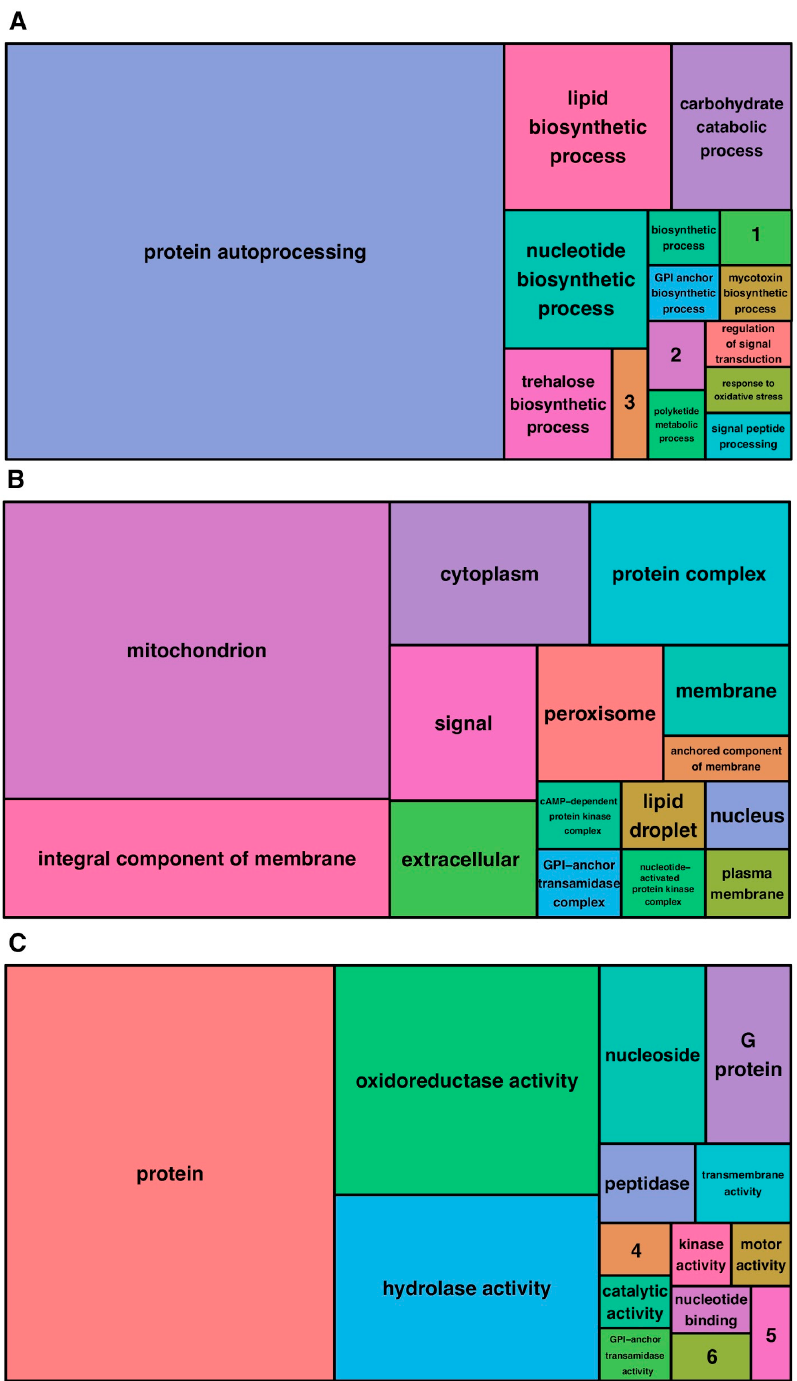
Figure 1. GOFeat annotation: Distinct identified genes proportionally displayed by main Gene Ontology categories. ( A ) Biological process. ( B ) Cellular component. ( C ) Molecular function. 1 aflatoxin biosynthetic process. 2 G protein-coupled receptor signaling pathway. 3 pathogenesis. 4 alpha,alpha-trehalose-phosphate synthase (UDP-forming) activity. 5 signal recognition particle binding. 6 triglyceride lipase